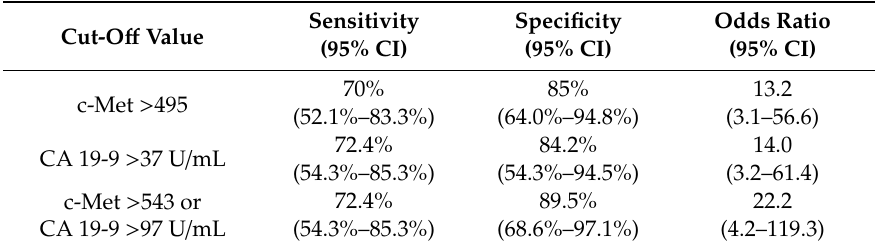
Table 5. Comparison of sensitivity, specificity and odds ratio of diagnostic test based on c-Met and CA 19-9 alone or in combination.